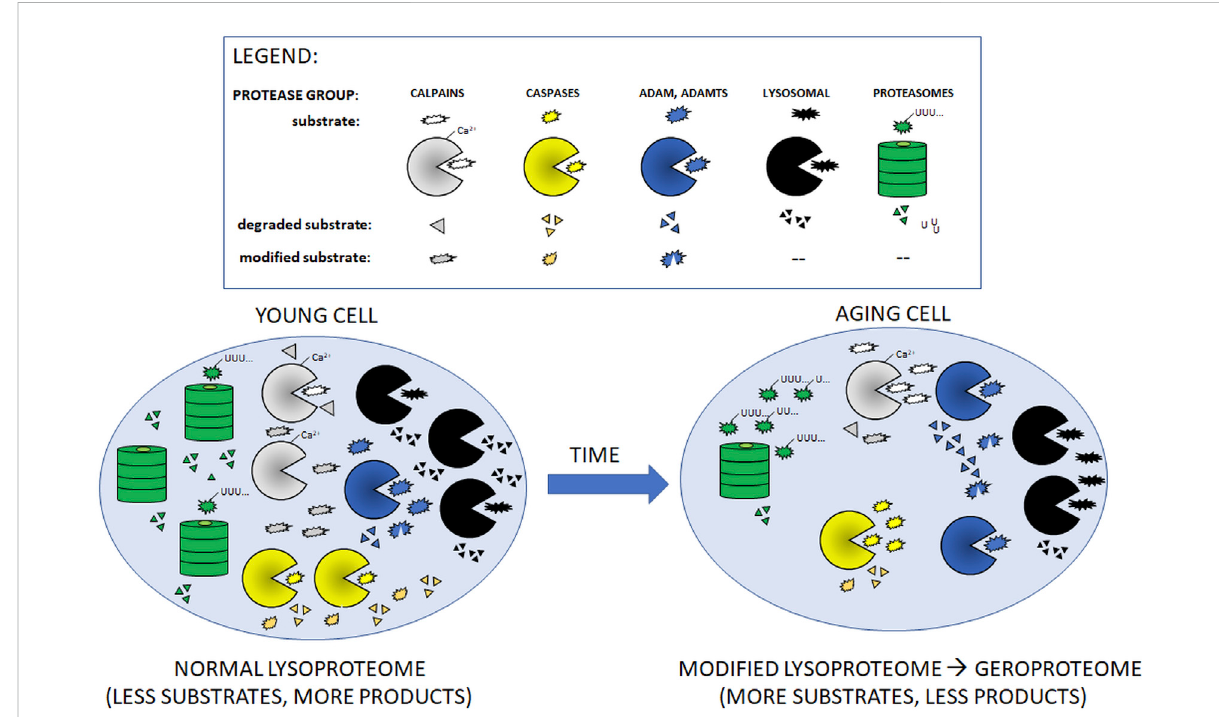
FIGURE 1 Cartoon presentation of aging-related changes in quantities/activities of main intracellular proteolytic systems described in Table 1. With the exception of ADAM and ADAMTS proteases, aging leads to decreased amounts/activities of the proteases (shown as fewer symbols of relevant protease in the aging cell as compared to young one). In consequence, aging cells accumulate more un-modi fi ed (non-functional) and undigested substrate